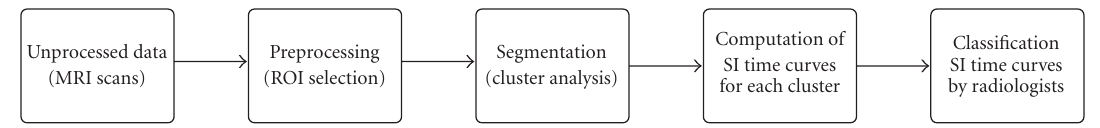
Figure 2: Diagram of the CAD system employed for the small mammographic lesion evaluation: the six MRI scans for each subject undergo a signal preprocessing, the ROI is determined and all voxels within it are subject to cluster analysis. The obtained time-signal intensity (SI) curves are compared to the four Kuhl classes from Figure 1 and automatically assigned to a class by the supervised neural network.